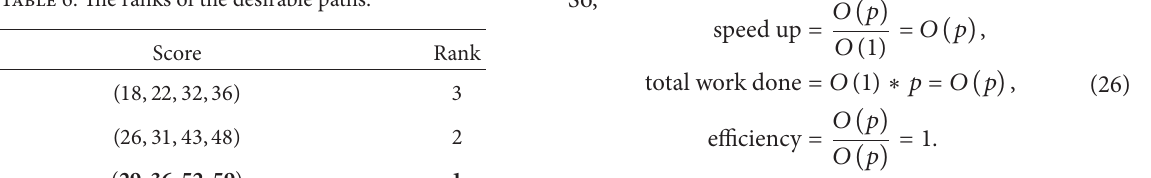
Table 6: The ranks of the desirable